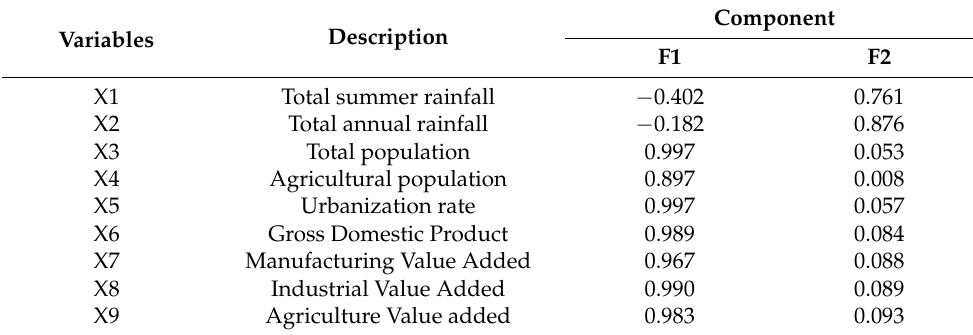
Table 6. Rotated component matrix of the principal component analysis.